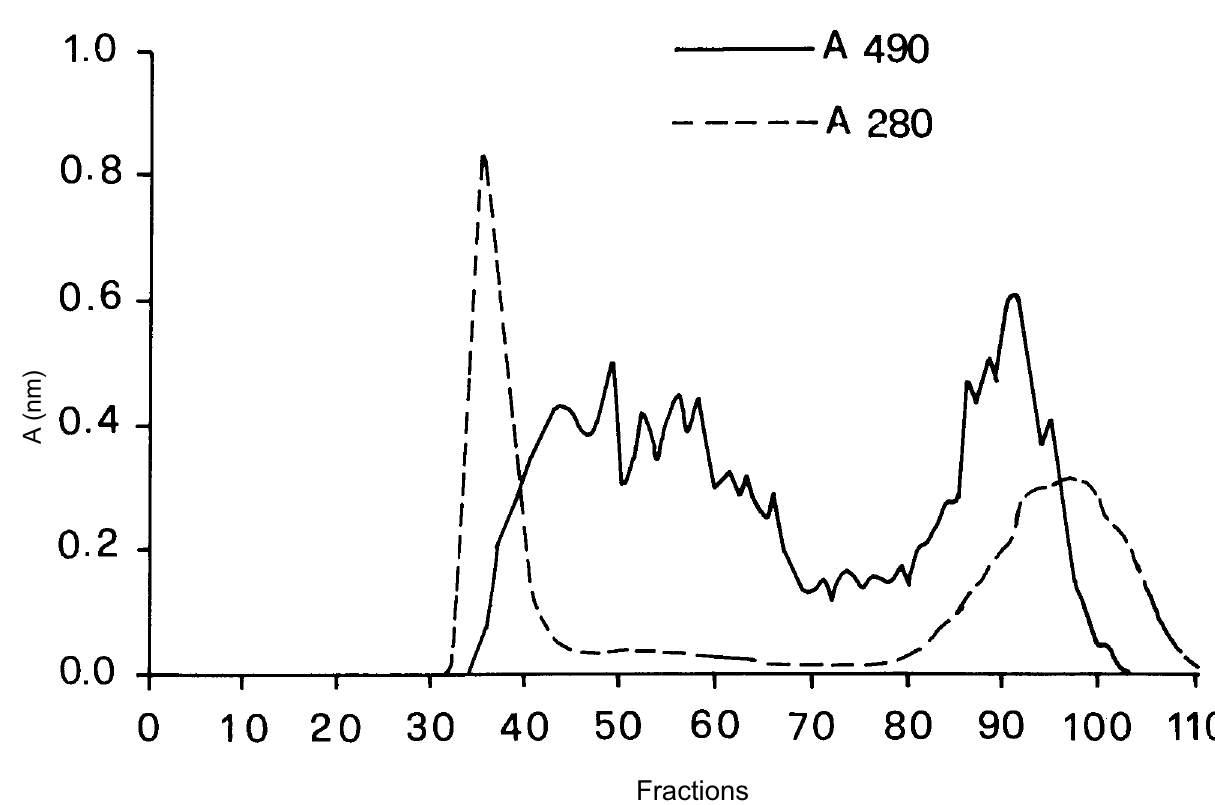
Fig. 1. Bio-Gel A1.5m of fraction A. Column conditions: 98 x 1.5 cm, 50 mMNaOAc, pH